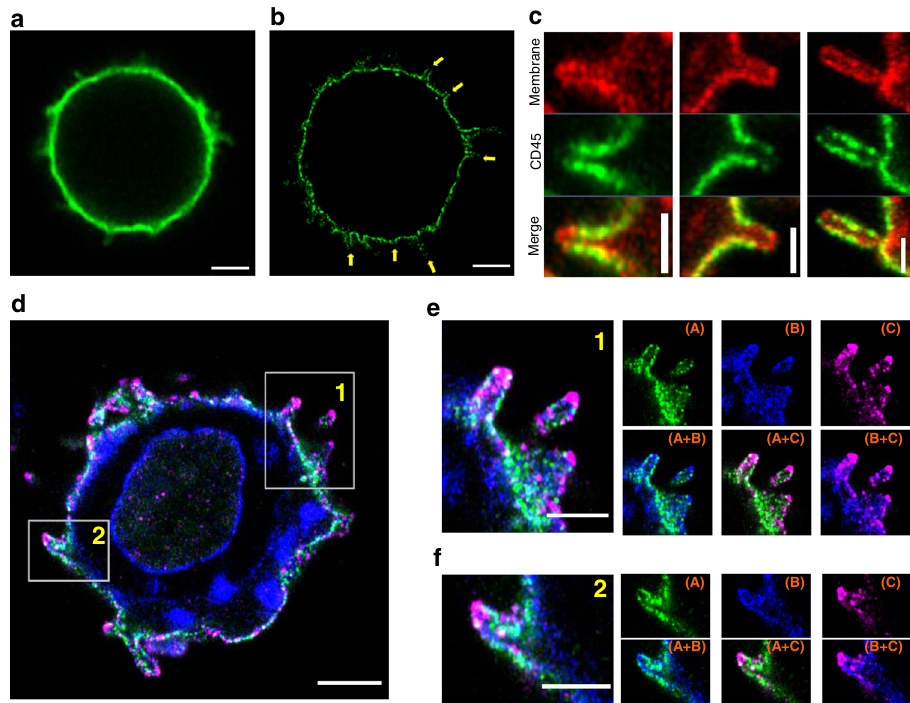
Fig. 1 Pre-exclusion of CD45 at the tips of MV on human CD4 + T cells. a A representative Airyscan image of a human CD4 + T cell labeled with Alexa Fluor 488 (AF488) conjugated anti-CD45 antibody. b A representative 4x-ExM-Airyscan image of a similarly labeled cell. Yellow arrows indicate MV tips. c Representative 4x-ExM-Airyscan images of MV on human CD4 + T cells stained with anti-CD45-AF488 (green) and FM 4-64FX membrane dye (red). d A representative 4x-ExM-Airyscan image of a human CD4 + T cell stained with anti-CD45-AF488 (green), FM 4-64FX membrane dye (blue) and anti- L -sel-AF568 (magenta). e , f Magni fi ed images of areas 1 and 2 marked by the rectangles in d . Individual channel images of CD45 (A), membrane (B), and L -sel (C) (right, upper panels) and merged images of (A) and (B), (A) and (C), and (B) and (C) (right, lower panels). These images are representative of nine cells observed in three independent experiments. Scale bars in a , b , d : 2 µ m; in c : 500 nm; e , f : 1 µ m. The scale bars are corrected by the expansion factor except for a